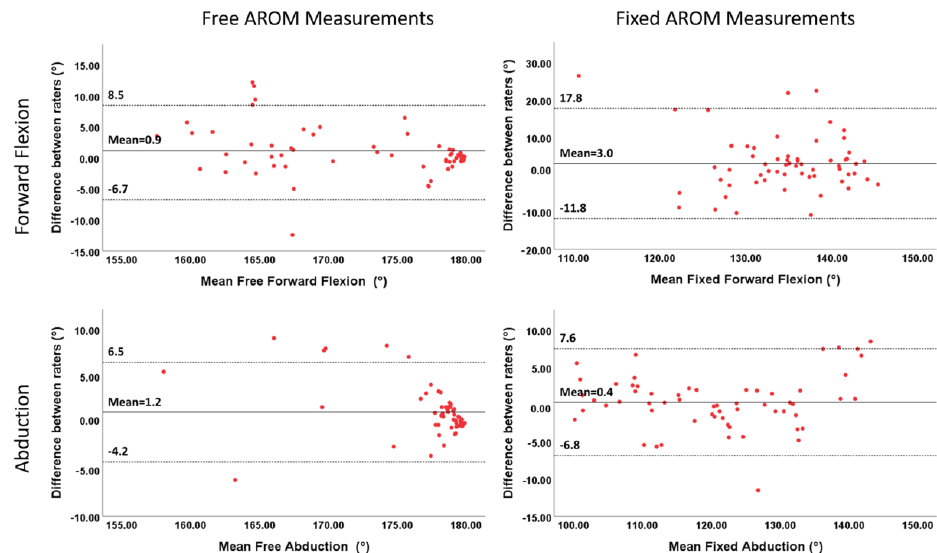
Figure 5. HumanTrak di ff erences between raters for free and fixed forward flexion and abduction AROM. The solid black line is the mean di ff erence between raters, and the segmented black lines show the 95% limits of